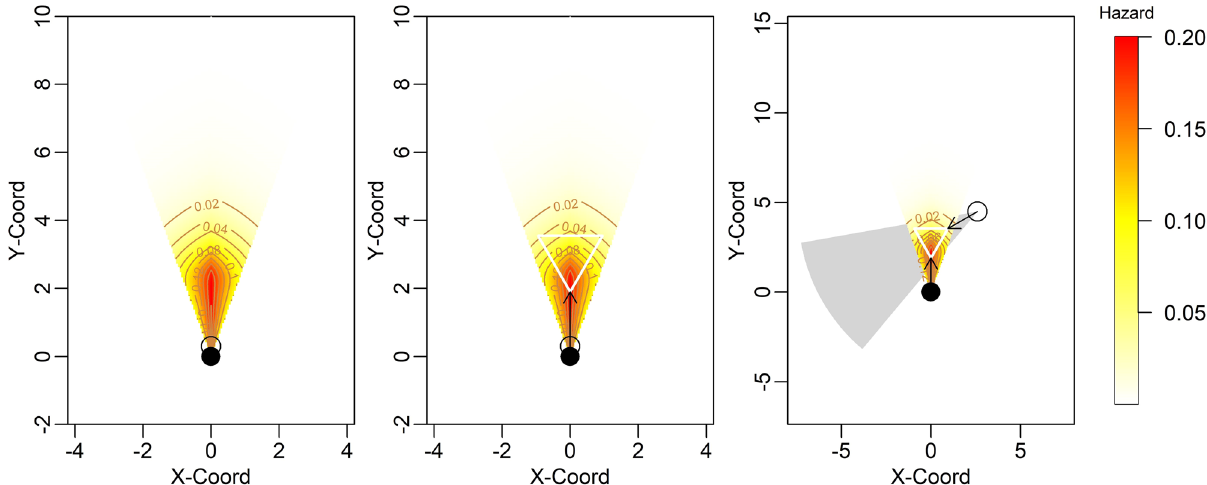
Figure 1. A schematic diagram showing the installations of three focal areas assumed in the simulation mimicking detection processes of moving animals. The circular sector shows the hazard landscape of the detection zone. The open and filled circle shows the positions of camera traps. In ins. 1 (left panel), the focal area was defined as the entire field of view within 10 m from the cameras. In ins. 2 (centre panel), the focal was restricted to an equilateral triangle with a side of 1.9 m. The distance from the camera to the nearest vertex was assumed to be 1.9 m (shown in white lines). Finally, in ins. 3 (right panel), the same equilateral triangle was monitored from different angles of 60°. The camera traps were assumed to have a sensor detection range of 42°. In the right panel, the landscape of the second camera trap was shown in a grey polygon.